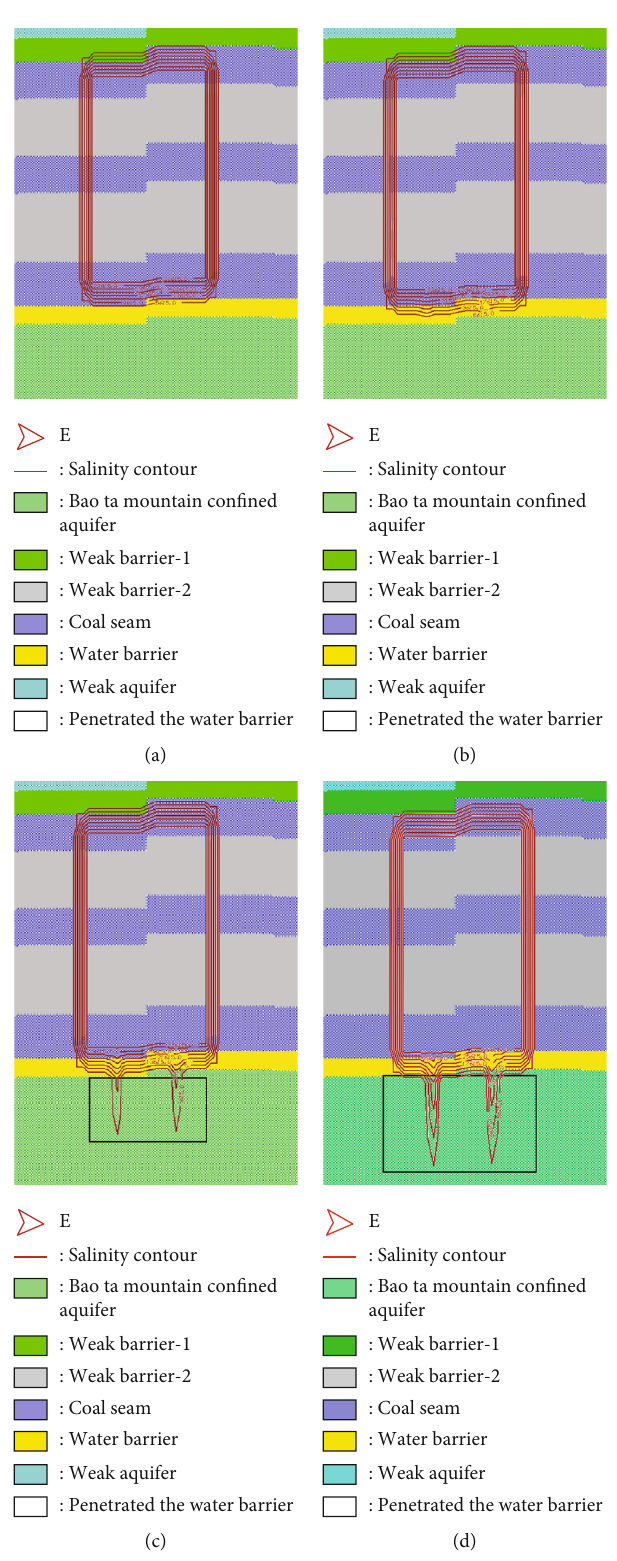
Figure 13: Migration of concentrated brine to the bottom water barrier at di ff erent times under sudden leak scenarios (the model is stretched 20 times the actual vertical direction, (a) is the initial state, (b) is 10 meters, (c) is 50 meters, and (d) is 100